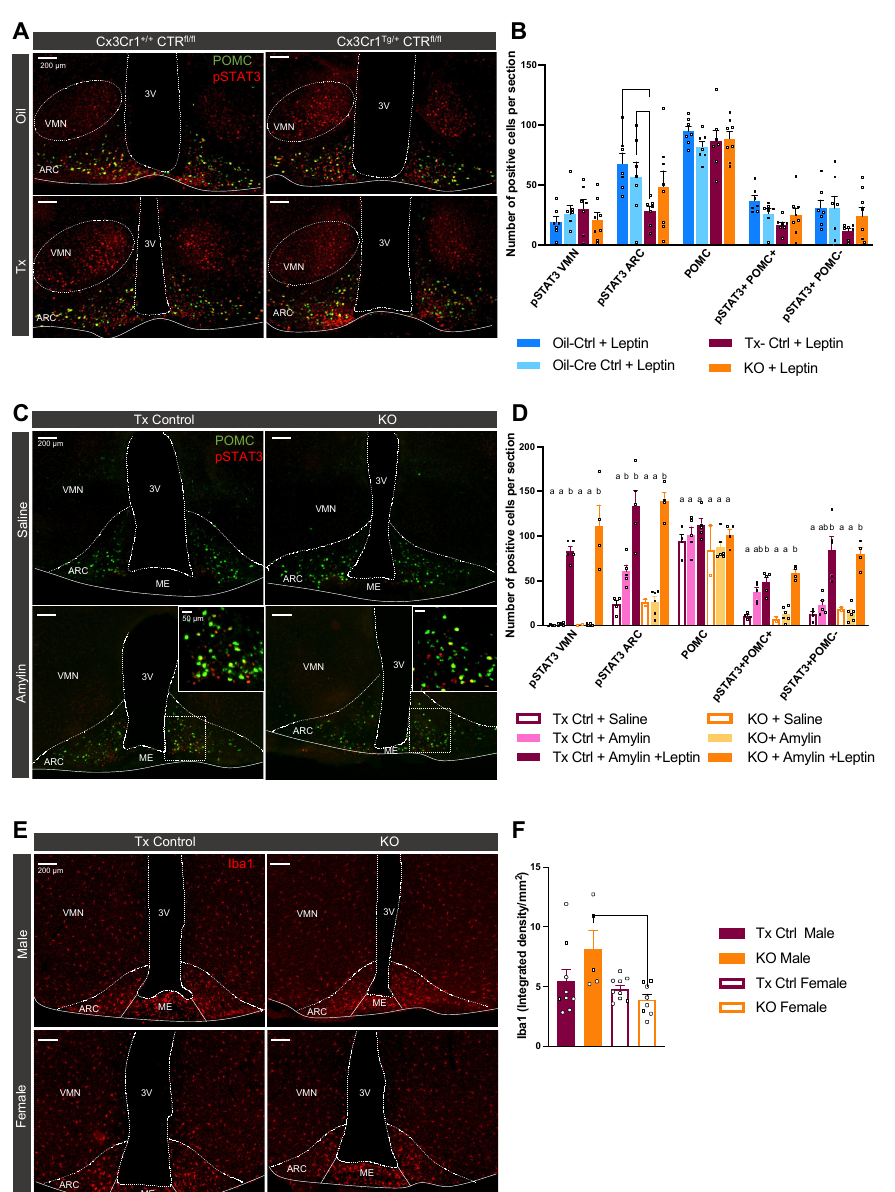
Figure 7. Amylin ‐ induced pSTAT3 is decreased in the ARC of KO mice but leptin ‐ and amylin + leptin ‐ induced pSTAT3 is similar to Tx ‐ controls. Chow ‐ fed mice (cohort 1, n = 7–8/group) were injected with leptin (5 mg/kg i.p.) 45 min before sacrifice. Brain sections were double-stained for pSTAT3 (red) and POMC (green) ( A ) and quantified ( B ). A second cohort of chow ‐ fed mice (cohort 2, n = 4–5/group) were injected with amylin (50 ug/kg i.p.) or amylin + leptin (5 mg/kg i.p.) 45 min before sacrifice. Brain sections were double ‐ stained for pSTAT3 (red) and POMC (green) ( C ) and quantified ( D ). HFD ‐ fed mice (cohort 3, n = 5–9/group) brain sections were stained for Iba1 (red) ( E ) and quantified ( F ). Data are displayed as mean ± SEM; * p < 0.05, ** p < 0.01 or data points with differing superscript letters (a,b) differ from each other by p = 0.05 or less after Tukey’s post hoc test for multiple comparisons. VMN: Ventromedial hypothalamic nucleus, ARC: Arcuate nucleus, 3V: Third ventricle, ME: median eminence.